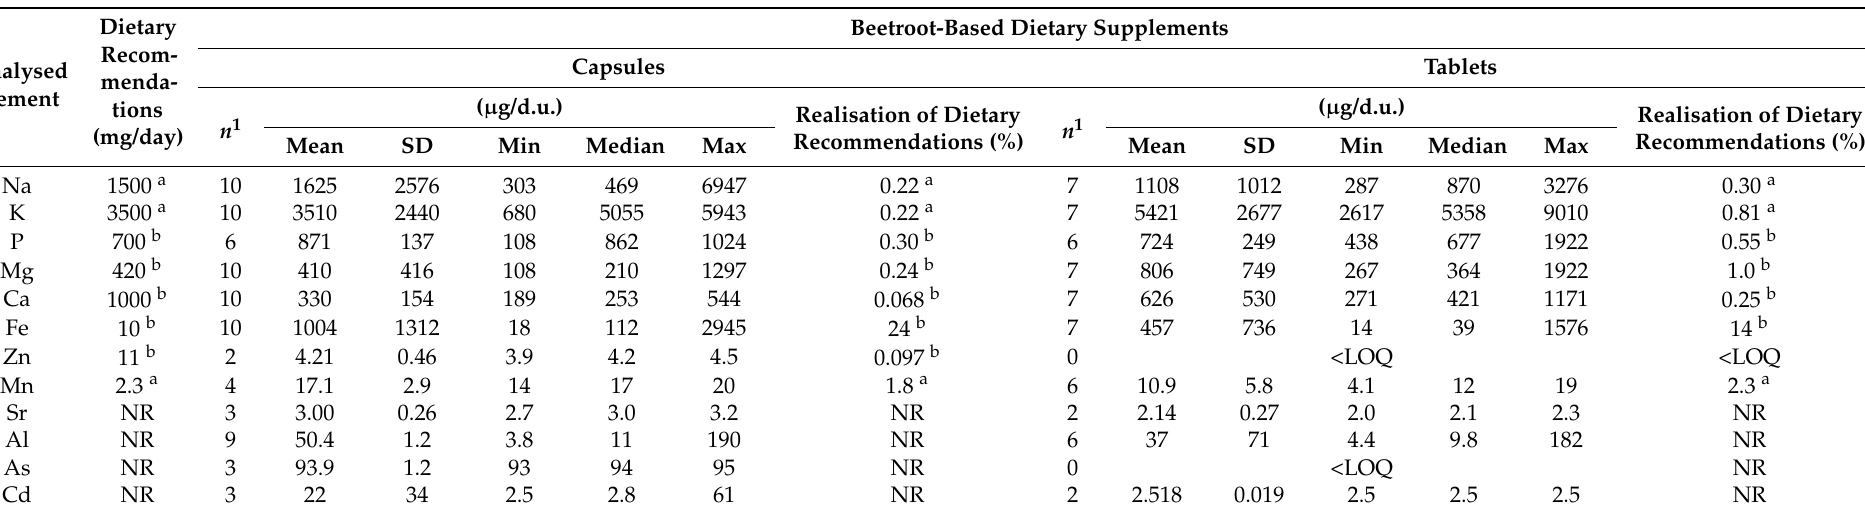
Table 5. Macro- and microelements’ contents in capsulated and tableted beetroot-based dietary supplements samples and realisation of dietary recommendations for adult male from 19 to 75 years old by a daily portion of the analysed dietary